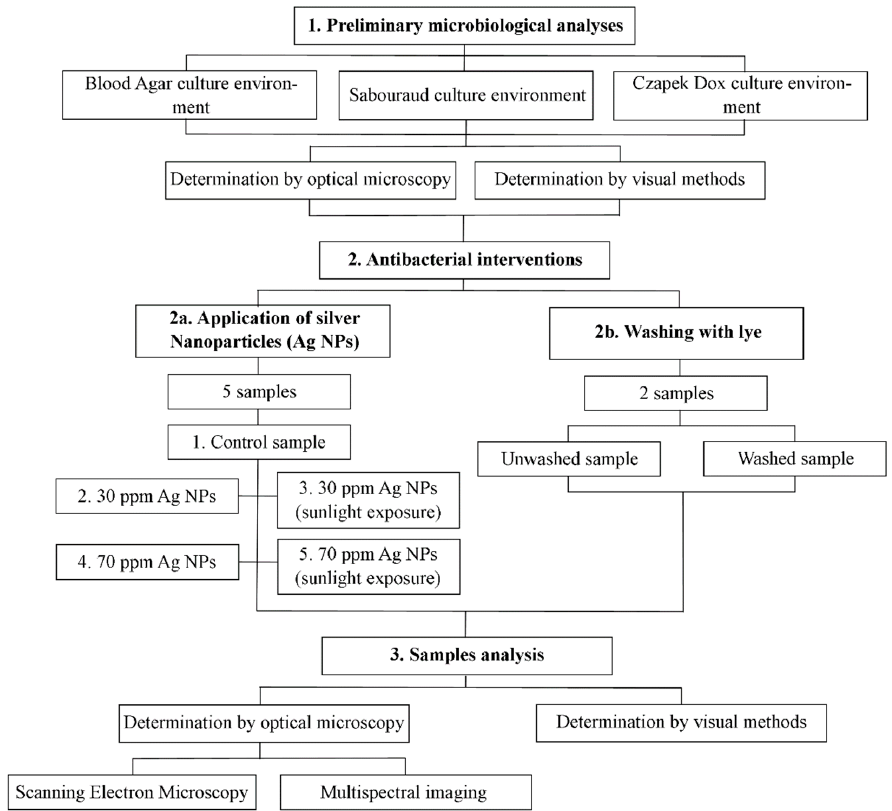
Figure 1. Schematic diagram of the main methodological stages of the study .